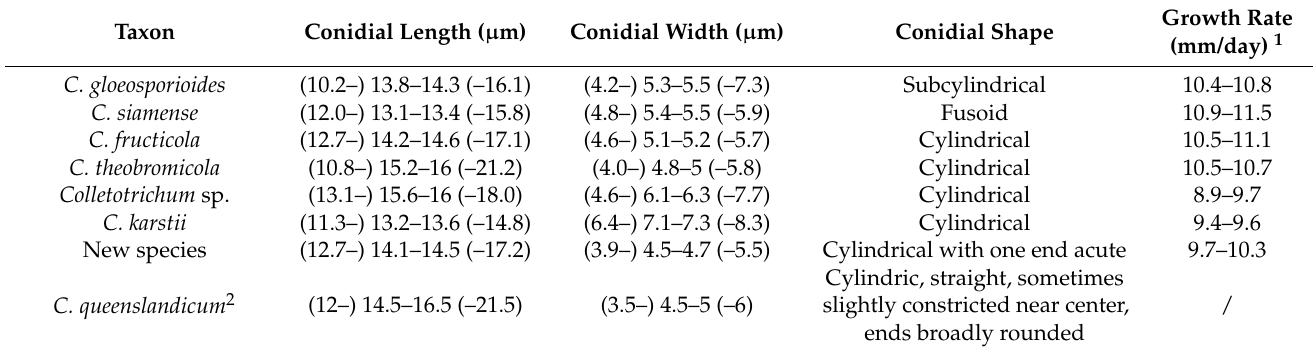
Table 3. Morphological characters of Colletotrichum